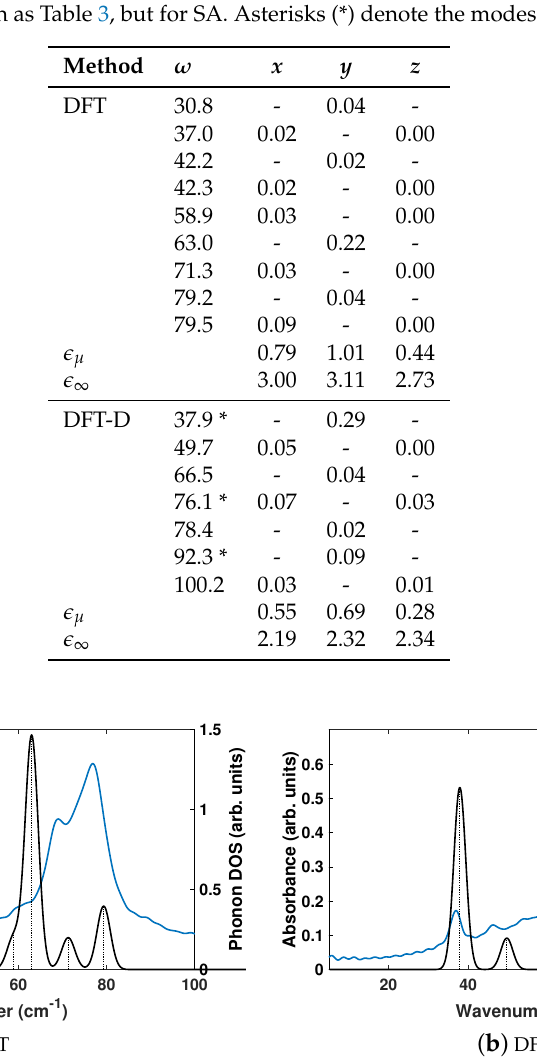
Figure 6. Same description as in Figure 2, but for salicylic acid